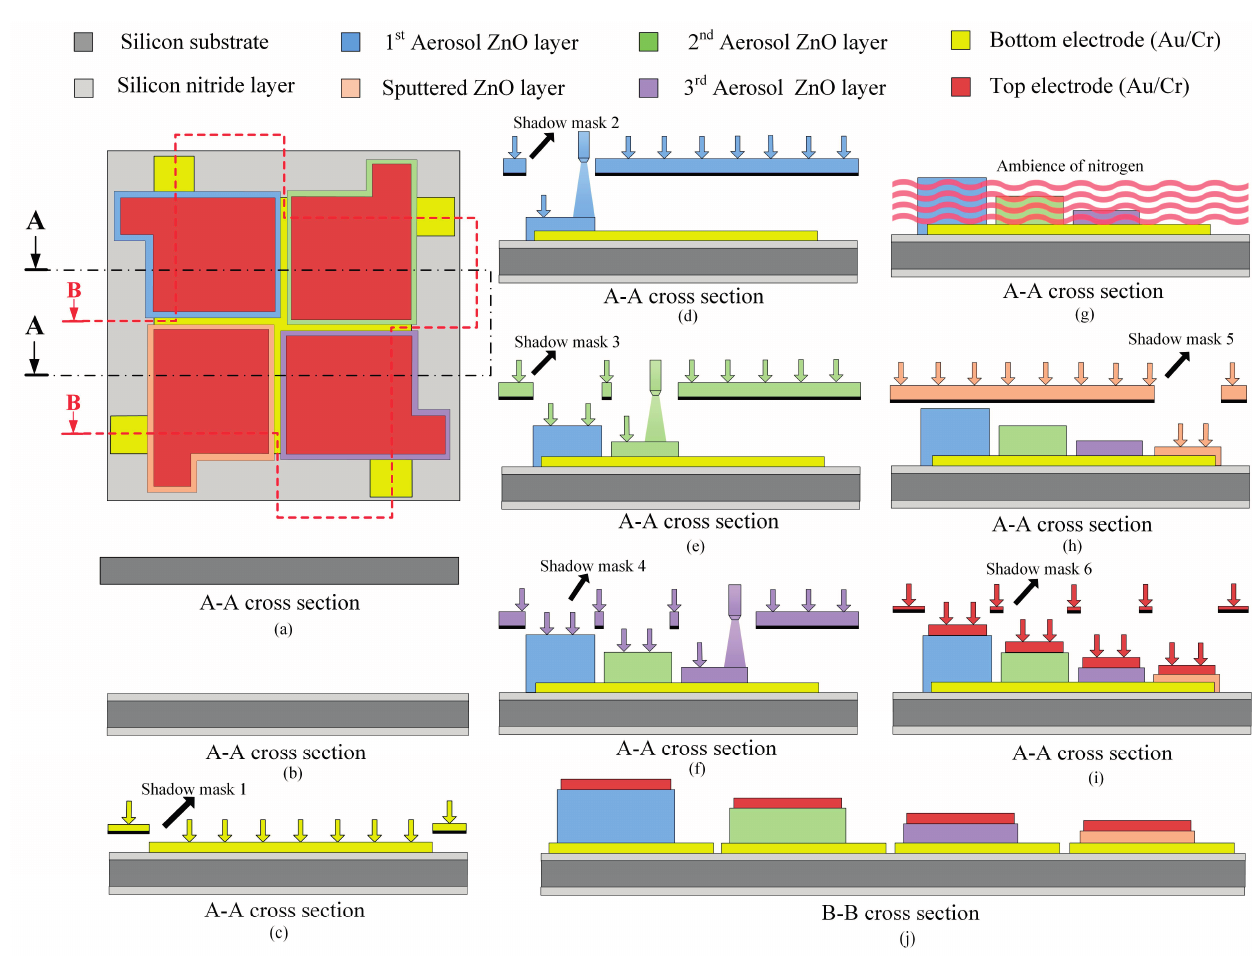
Figure 3. Fabrication procedure of the meliorated multi-frequency band pyroelectric